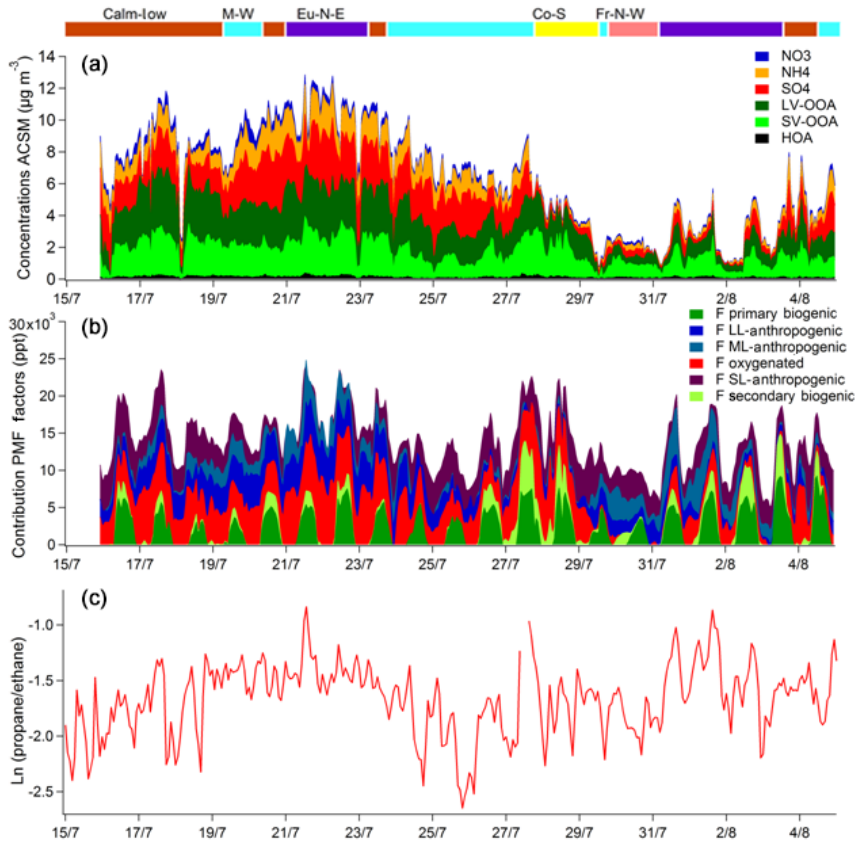
Figure 12. Stacked time series of aerosol fractions (top panel), VOC PMF factors (middle panel) and ln(propane/ethane) as a proxy for photochemical age (bottom panel). F-LL, F-ML and F-SL anthropogenic refer to the long-lived, medium-lived and short-lived anthropogenic factors, respectively. The colored areas at the top correspond to back-trajectory clusters: light blue, purple, yellow, pink and orange-brown for the marine west (M-W), Europe northeast (Eu-N-E), Corsica south (Co-S), France northwest (Fr-N-W) and calm low wind (calm-low) clusters,